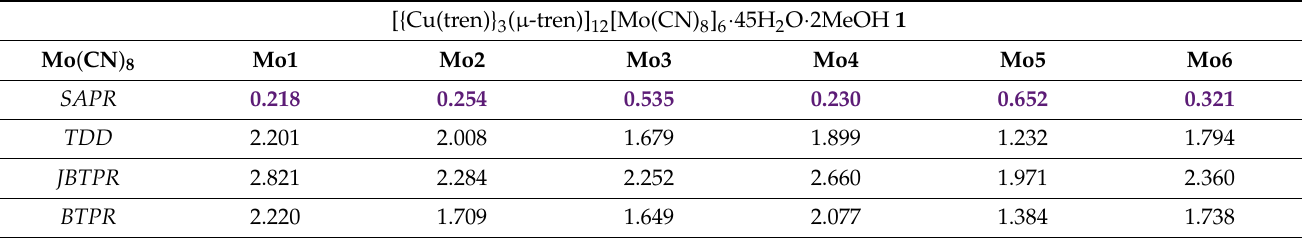
Table A2. Continuous shape measurements (CShM) for metal ions in 1 , 2 and 3